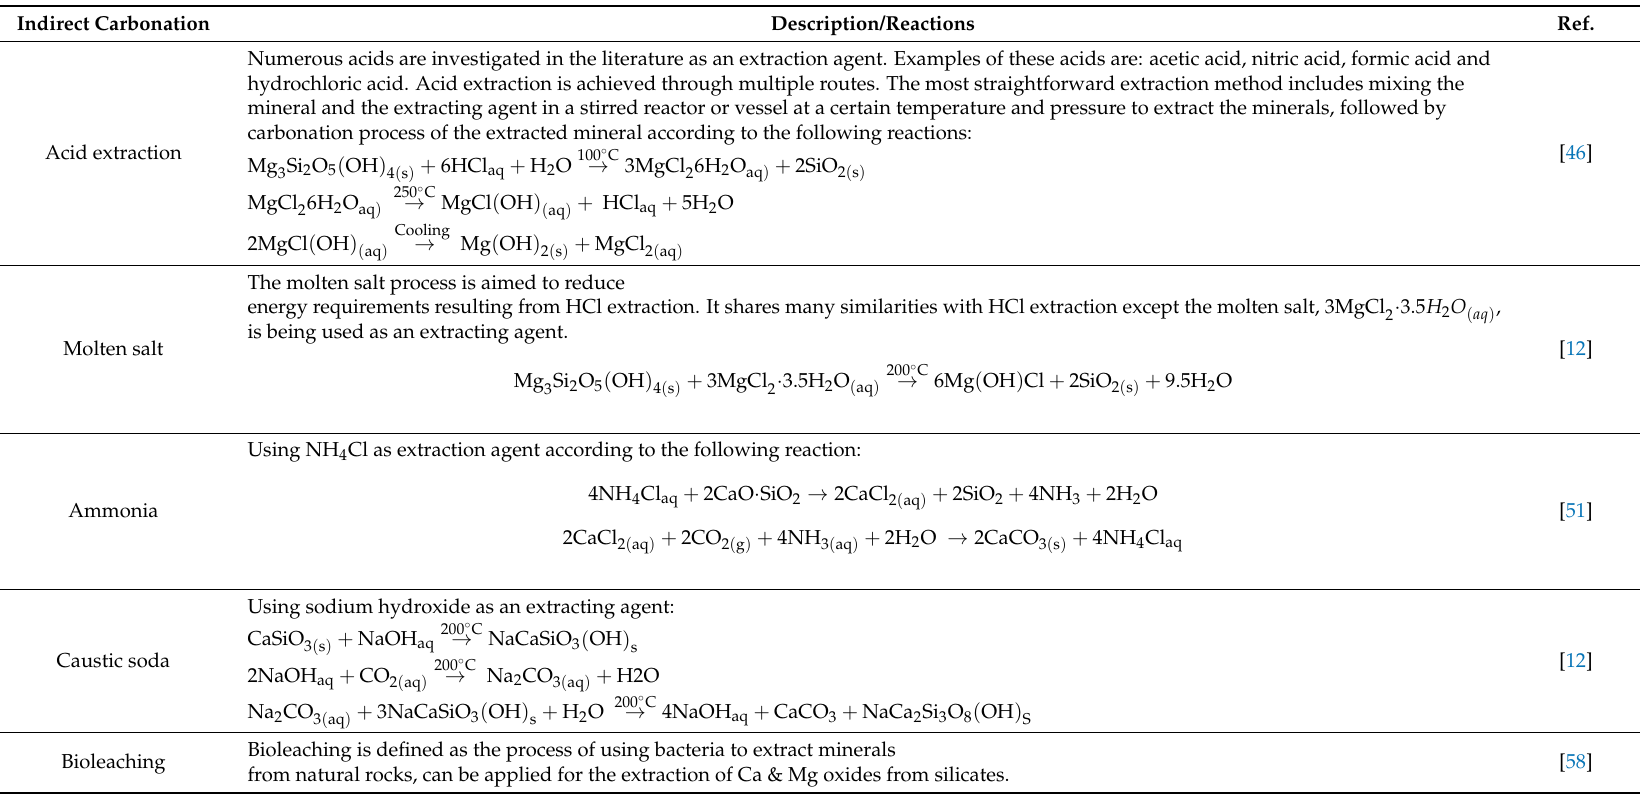
Table 6. Description of different indirect carbonation